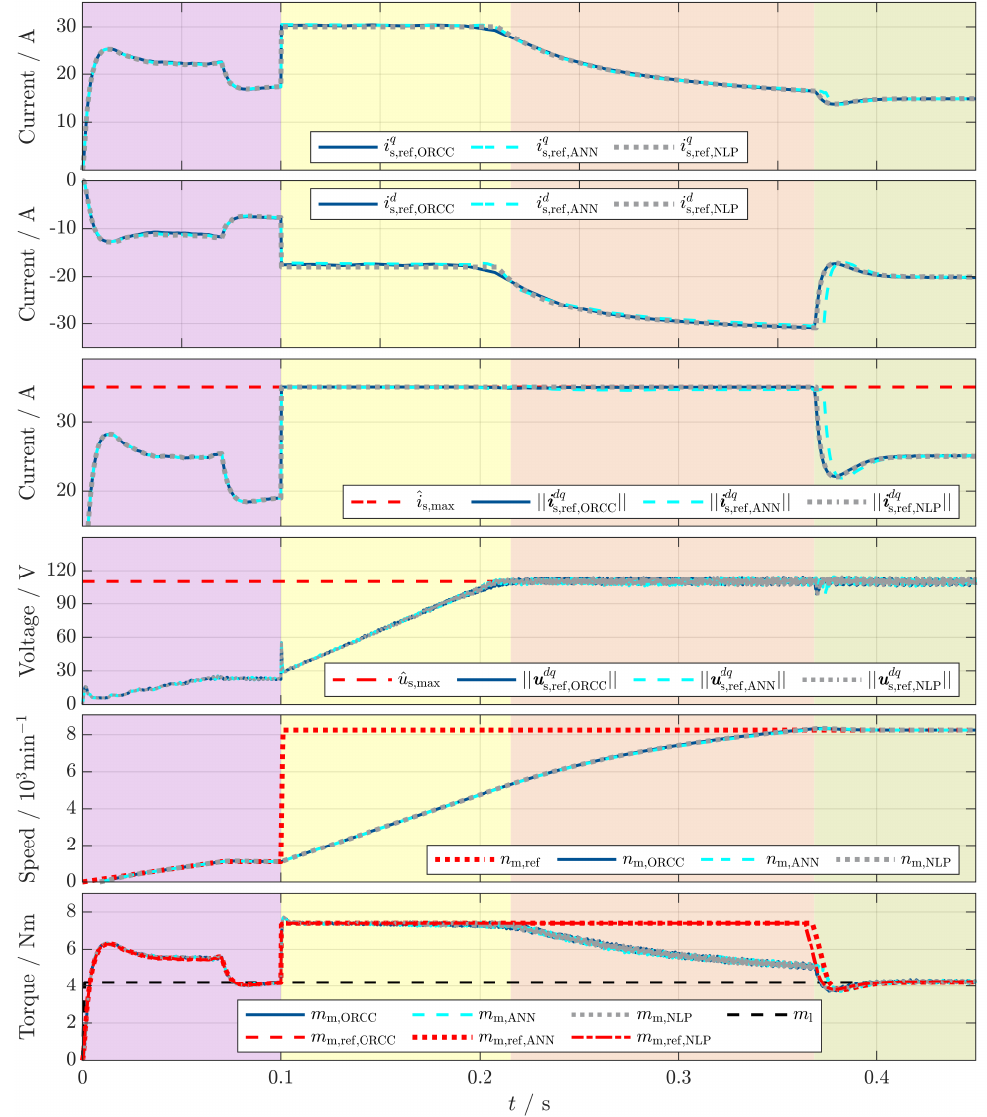
Figure 21. Implementation results: Direct comparison between OFTC with analytical ORCC = ORCC ana [ ], ANN-based OFTC [ ] and OFTC solved directly by fmincon (NLP) [